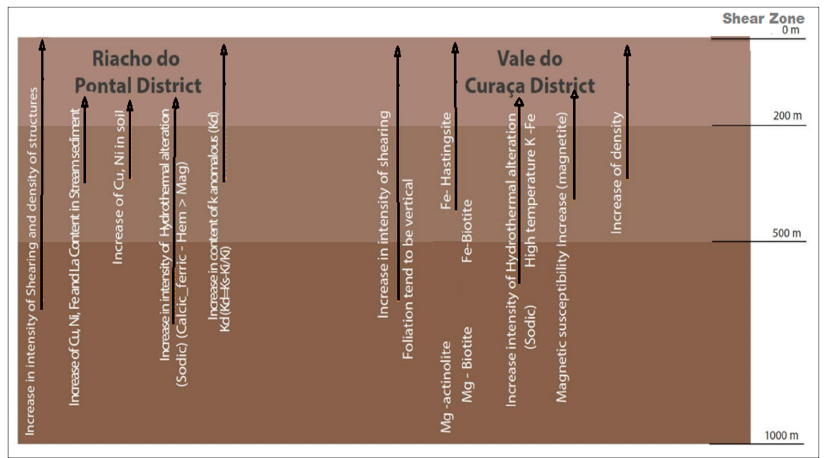
Figure 14. The main geological geochemical, structural, and geophysical vectors illustrating the footprint of the Vale do Curaçá and Riacho do Pontal Copper Districts (modified from [76]).